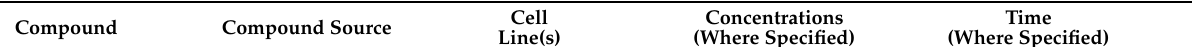
Table 2. Natural compounds as in vitro inducers of